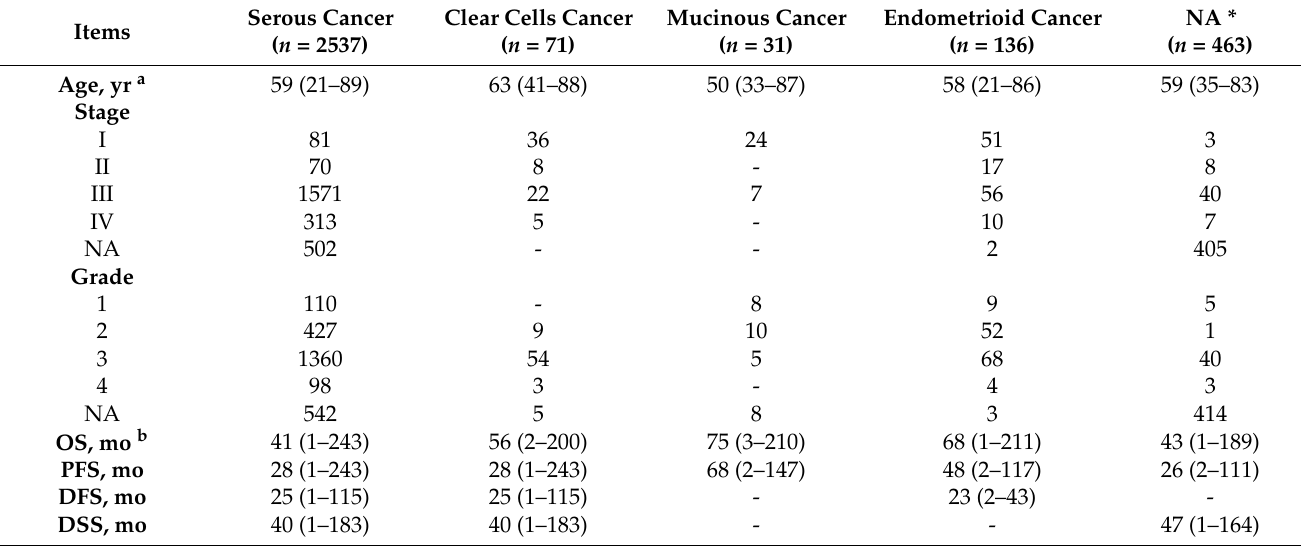
Table 1. Summary of clinicopathological features of ovarian cancer in